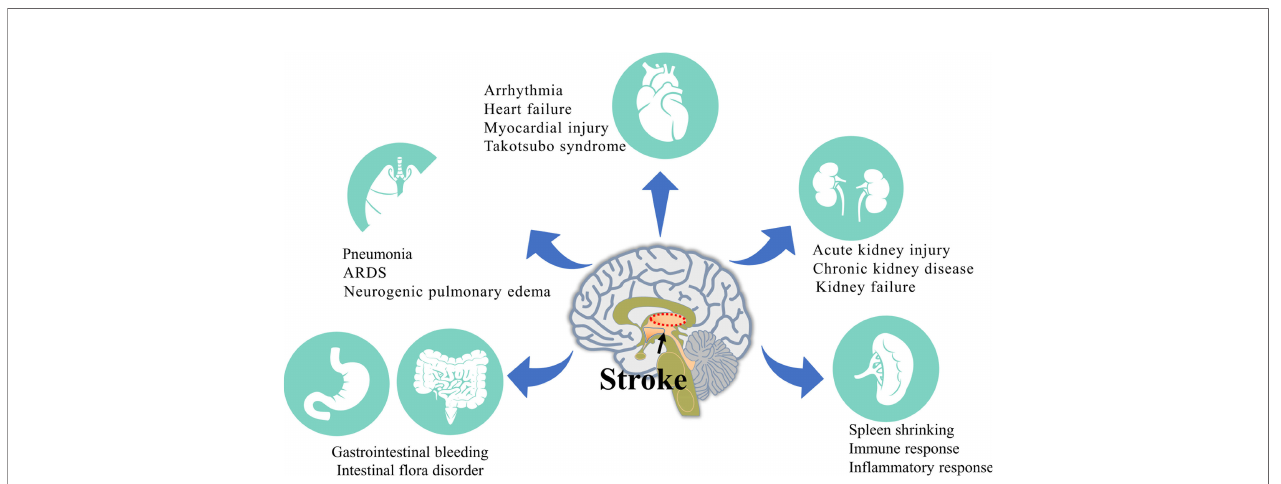
FIGURE 1 | Injury of various peripheral organs after stroke. The activation of sympathetic nerve, hypothalamus-pituitary-adrenal axis and immune system after stroke leads to a series of systemic events and fi nally leads to the injury of various peripheral organs. The most common peripheral injuries include the Lung, Heart, Gastrointestinal tract, Kidney and